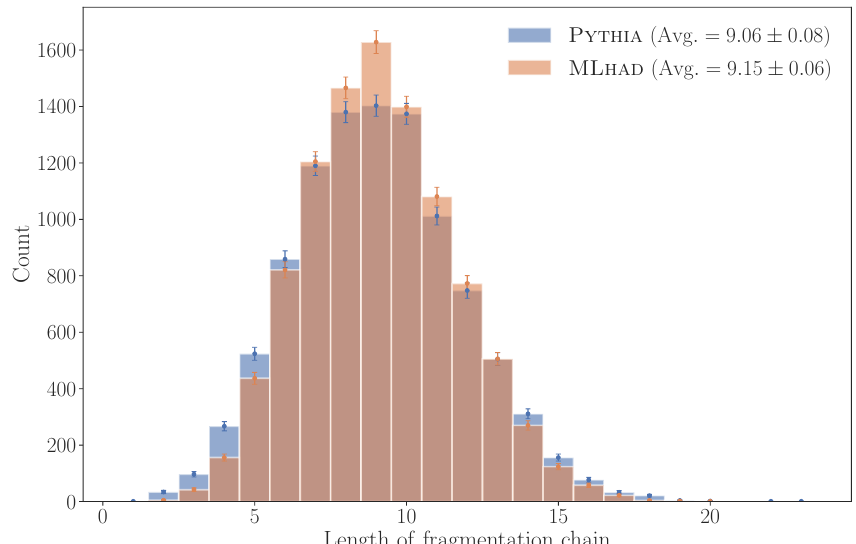
Figure 11: Comparison of the number of hadrons produced in the fragmentation chain of a single string for a sample of 10 4 strings, compared between P YTHIA (blue) and ML HAD (red) generated hadronization